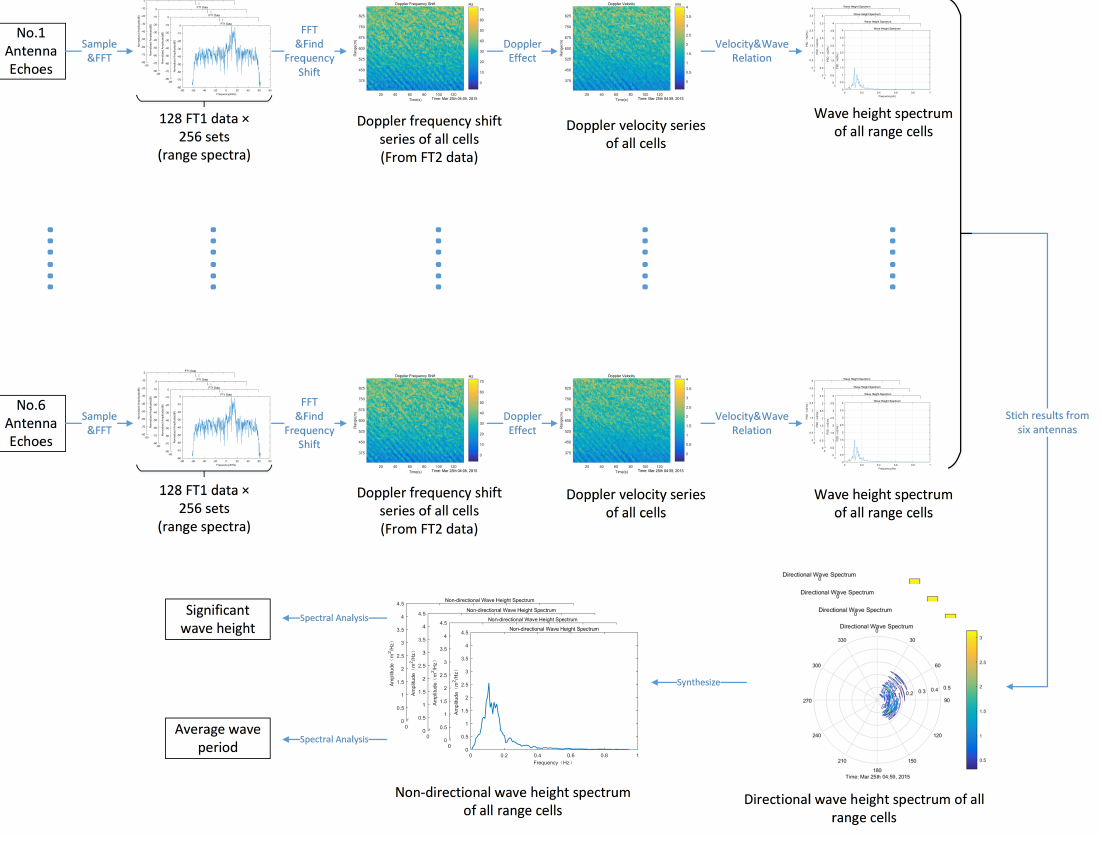
Figure 7. Data processing approach of MORSE, from echoes of every antenna to the final